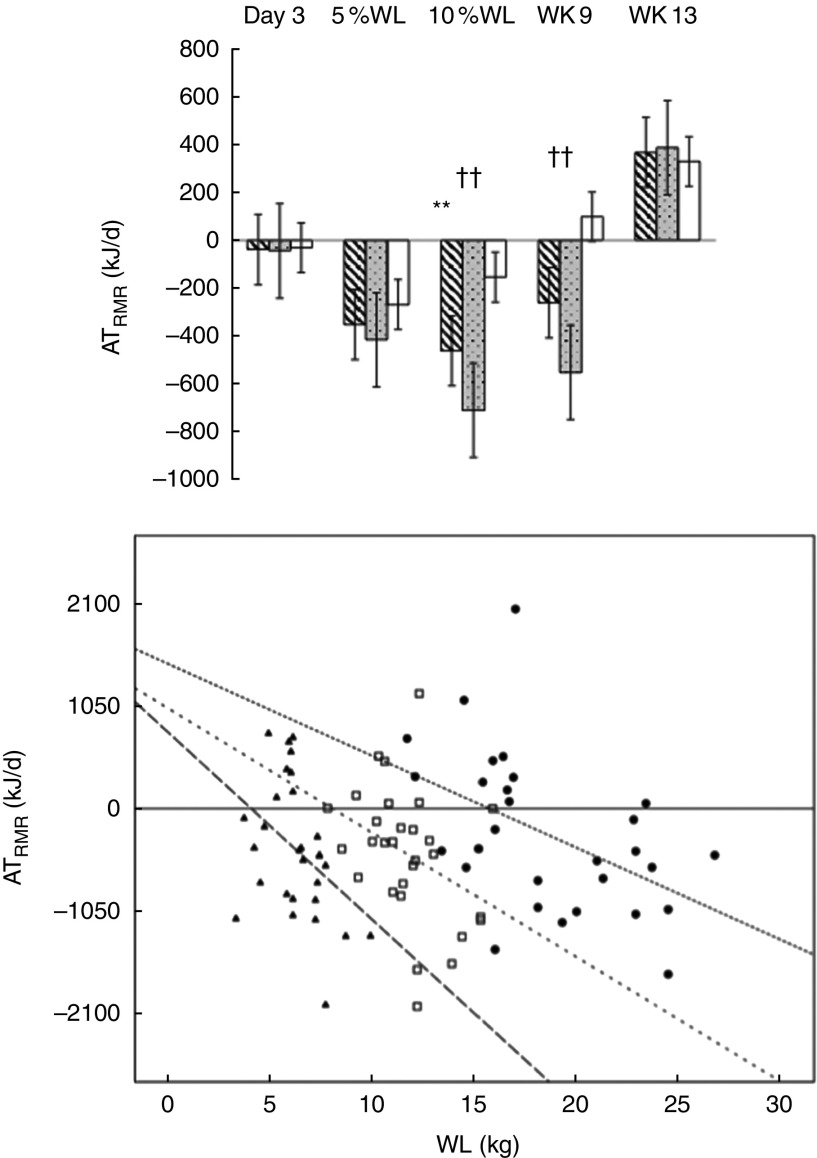
(a). Adaptive thermogenesis (AT) at the level of RMR with progressive weight loss (WL), in all participants (), men () and women (). Values are means with their standard errors. Wk9, week 9; Wk13, week 13. RMRmeasured<RMRpredicted: **P<0·01 for all, ††P<0·01 for males. (b). Correlation of ATRMR against WL at 5 %, 10 % and week 9 in all participants was investigated by using Spearman’s ρ correlation coefficient; a larger ATRMR was associated with a larger WL. The equation for the regression lines: 5 % WL; Y=−210×X+962, 10%WL; Y=−126×X+1025, and week 9; Y=−92×X+1483. , ATRMR 5 % WL, R
2=0·241 (P<0·01); , ATRMR 10 % WL, R
2=0·153 (P<0·05); , ATRMR W9, R
2=0·285 (P<0·01).